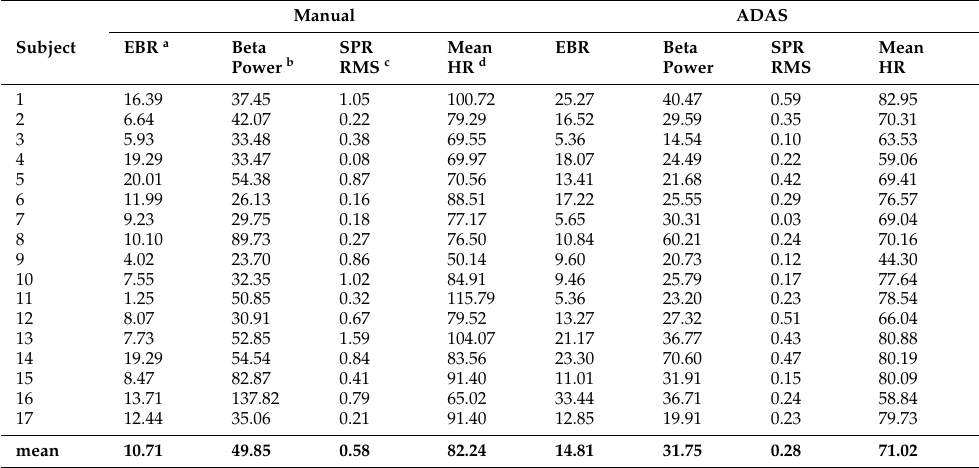
Table 3. EBR, mean beta power, SPR RMS, and mean HR computed for each subject and each driving